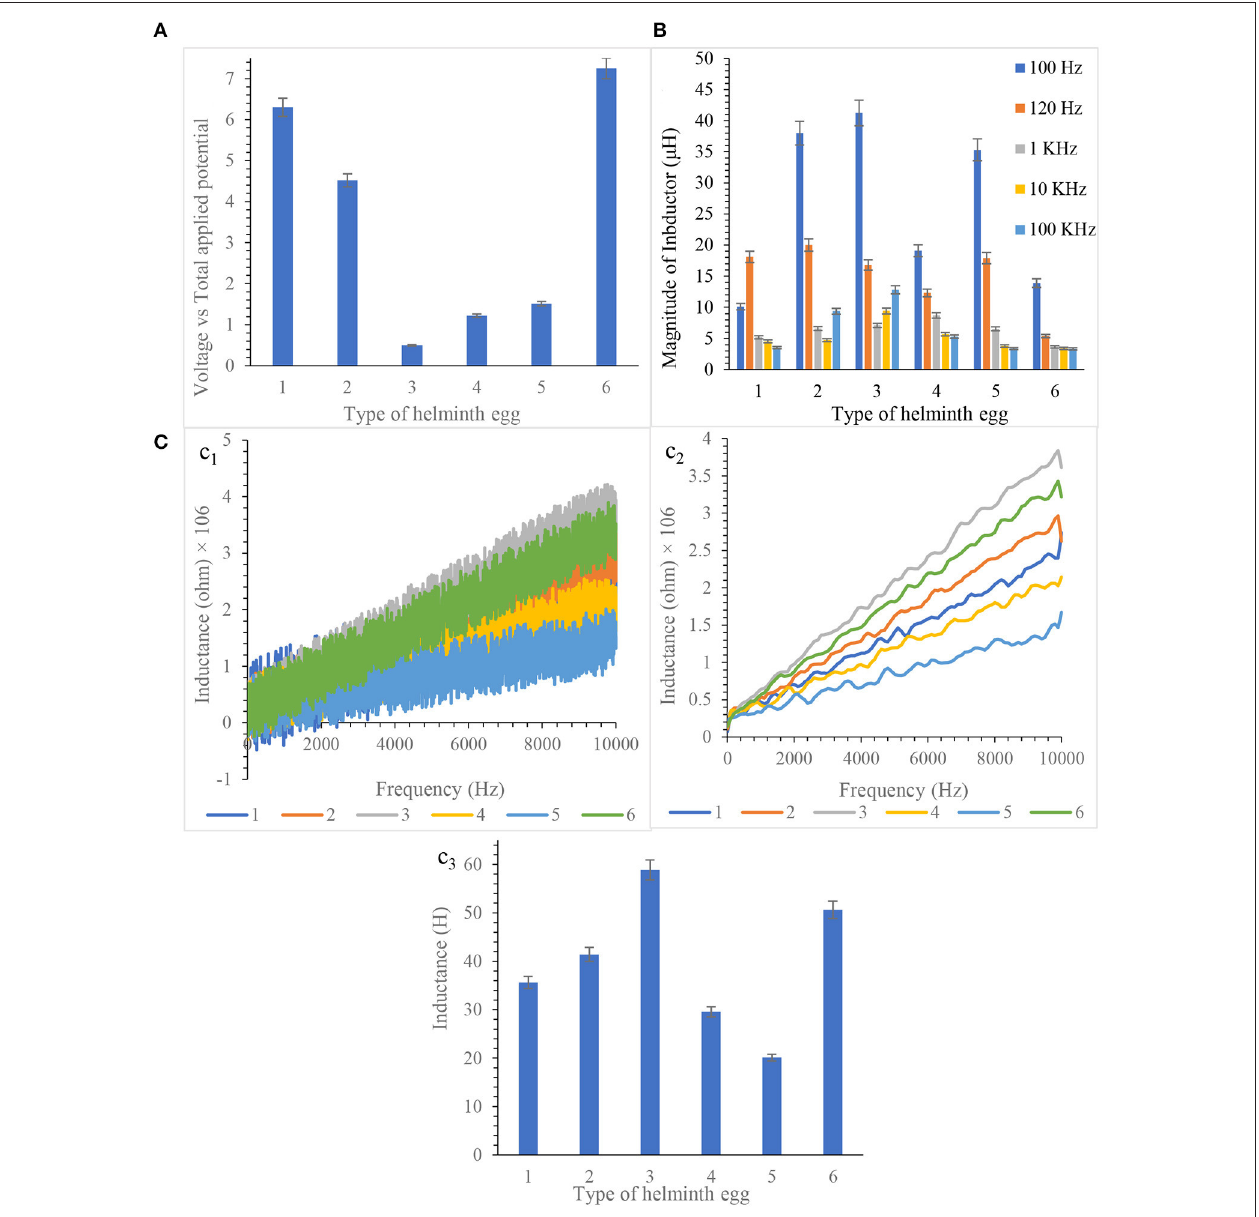
FIGURE 2 | (A) Hall effect measurement at 250kHz frequency, (B) Inductance determination by LCR meter, and (C) Inductance measurement by frequency scanning from 10.0 MHz to 10.0Hz based equivalent circuit (c 1 Non- smoothed, c 2 smoothed, c 3 Final Results). Note that, to prevent clutter, error bars are eliminated. Measurements taken during five repetitions implanting three microelectrodes with 0.0124 ( n =